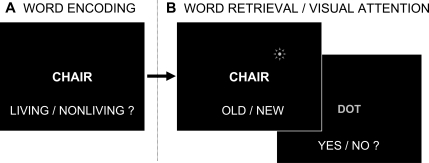
Visual Attention TaskThe task involved two phases: a word encoding phase and a word retrieval/visual attention phase. During the word encoding phase (A), participants studied words while making semantic (living/nonliving) decisions about the study items. During word retrieval/visual attention phase (B), participants performed an old/new word recognition task including old words presented at word encoding as well as new words that were not seen at study. On half of the trials, a small dot was flashed in the background during word recognition. After every recognition response, a second response was required to indicate visual detection of the target dot.